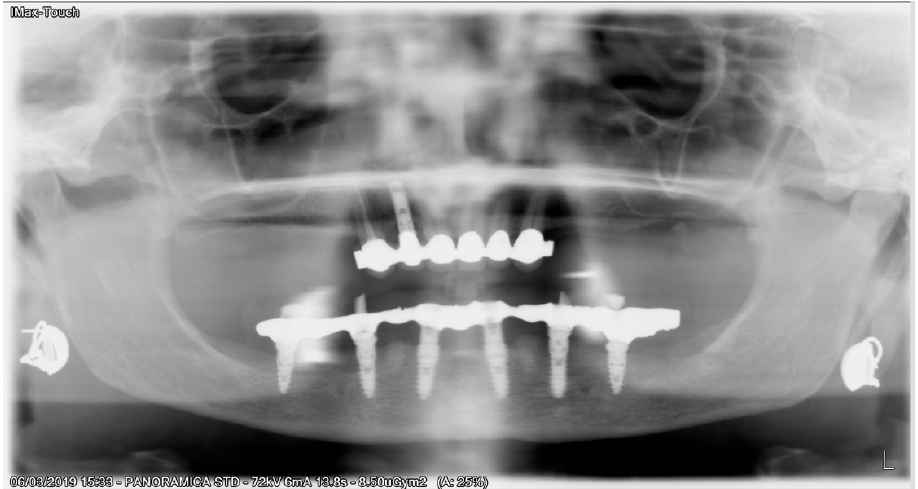
Figure 7. 2 years postoperative panoramic X-ray.